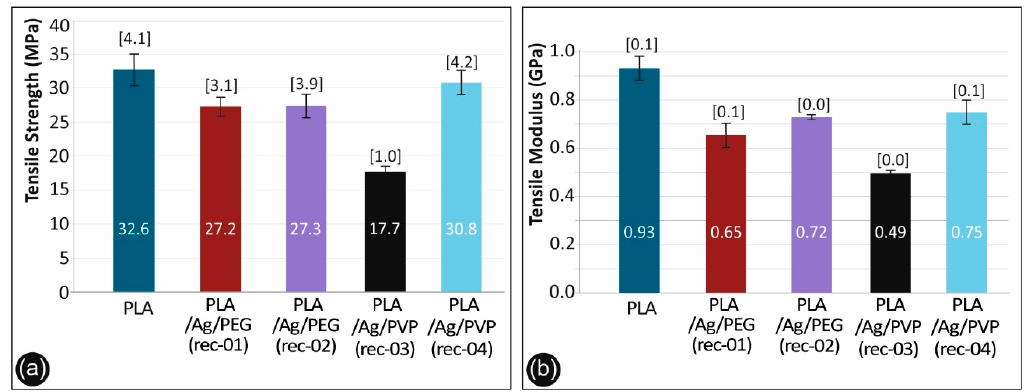
Figure 12. ( a ) Comparative tensile strength graph and ( b ) tensile mod. of elasticity for all the materials studied.